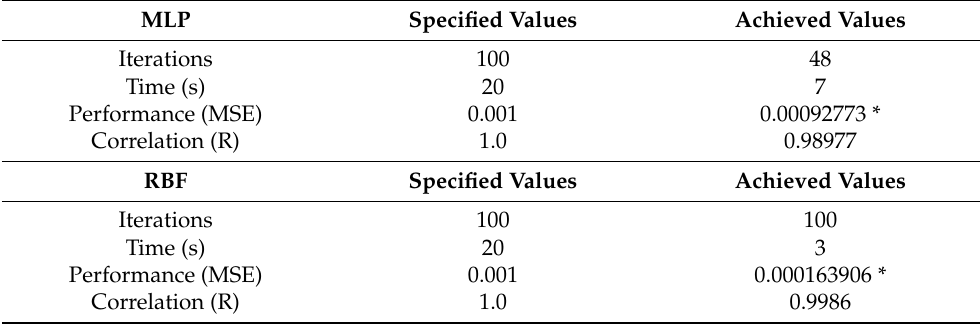
Table 1. Values specified and achieved in training MLP and RBF networks compared to Y des output.